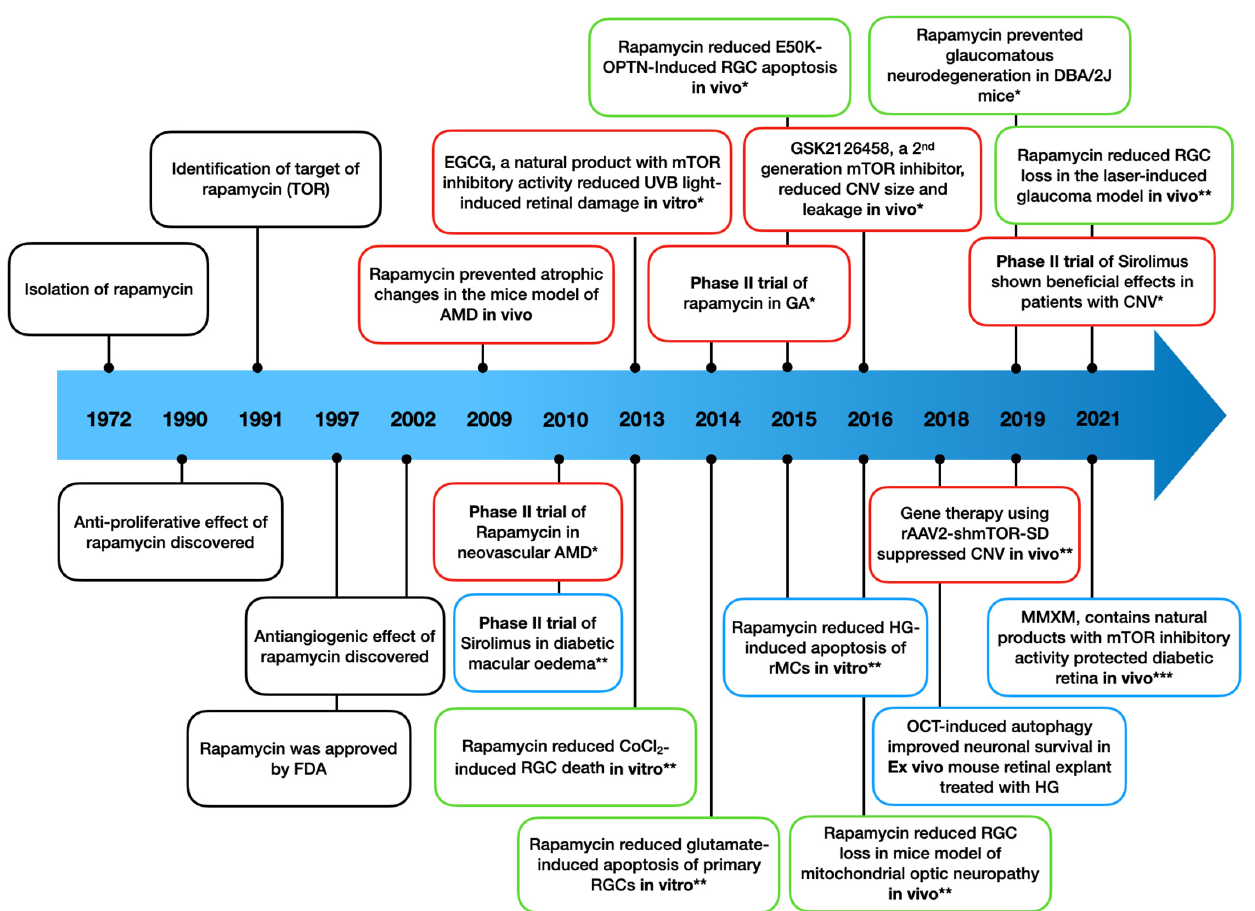
Figure 4. Timeline of mTOR inhibitors from discovery to the clinic for the treatment of ocular neurodegenerative diseases. Abbreviations: AMD, age-related macular degeneration; CNV, choroidal neovascularization; EGCG, epigallocatechin gallate; HG, high glucose; GA, geographic atrophy; MMXM, Mingmu Xiaomeng; OCT, octreotide; OPTN, optineurin; RGC, retinal ganglion cell; rMCs, retinal Müller cells. References in the figure: 1992 [55], 1990 [60], 1991 [1], 1997 [63], 2002